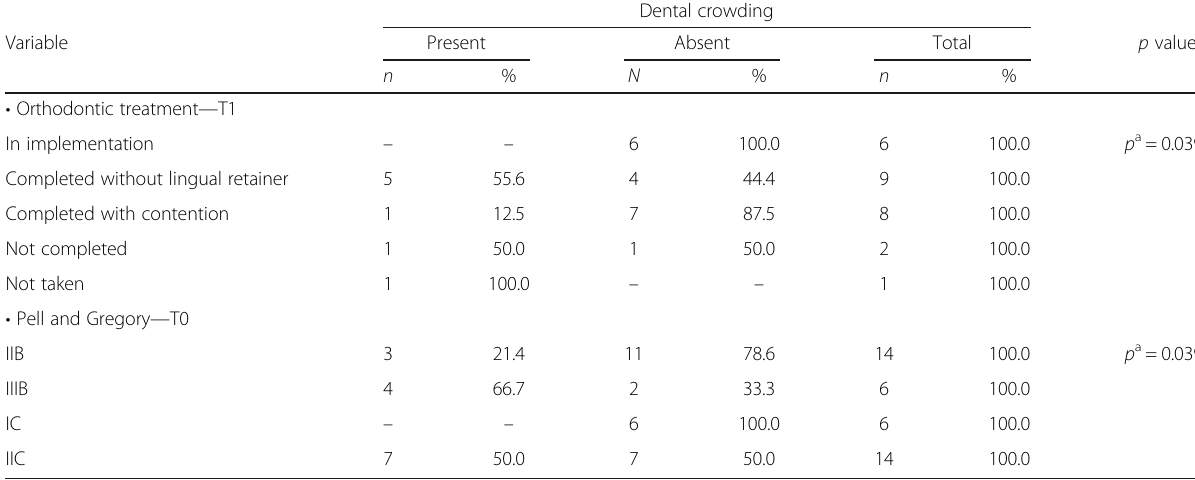
Table 4 Evaluation of the prevalence of crowding presenting with orthodontic treatment (T1) and the initial Pell and Gregory classification